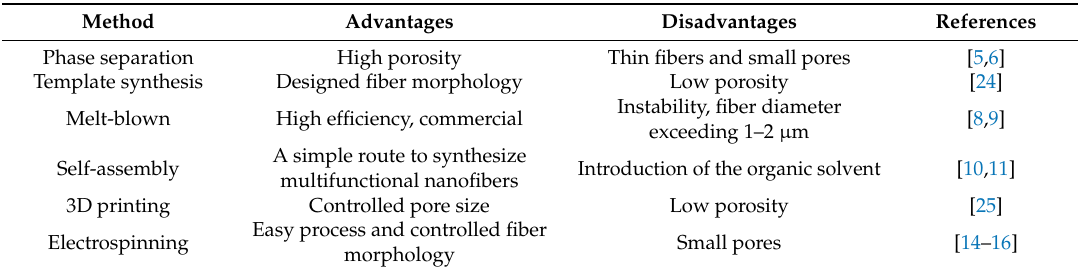
Table 1. Some fabrication methods for nanofiber mats.